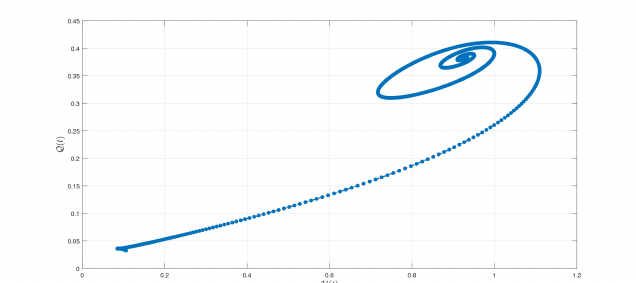
Figure 11. Behaviors of pair of sub-classes H ( t ) − Q ( t ) .